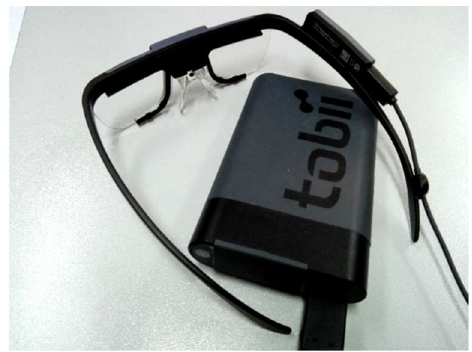
Figure 6. Eye tracking software Tobii Pro Glasses 2.